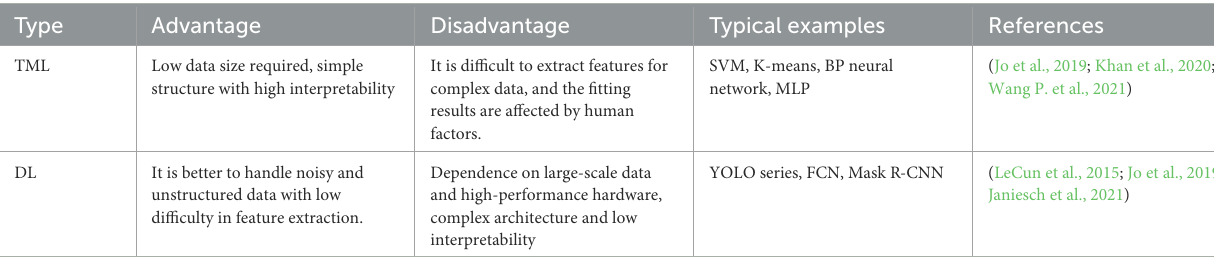
TABLE 1 Summary of commonly used machine learning